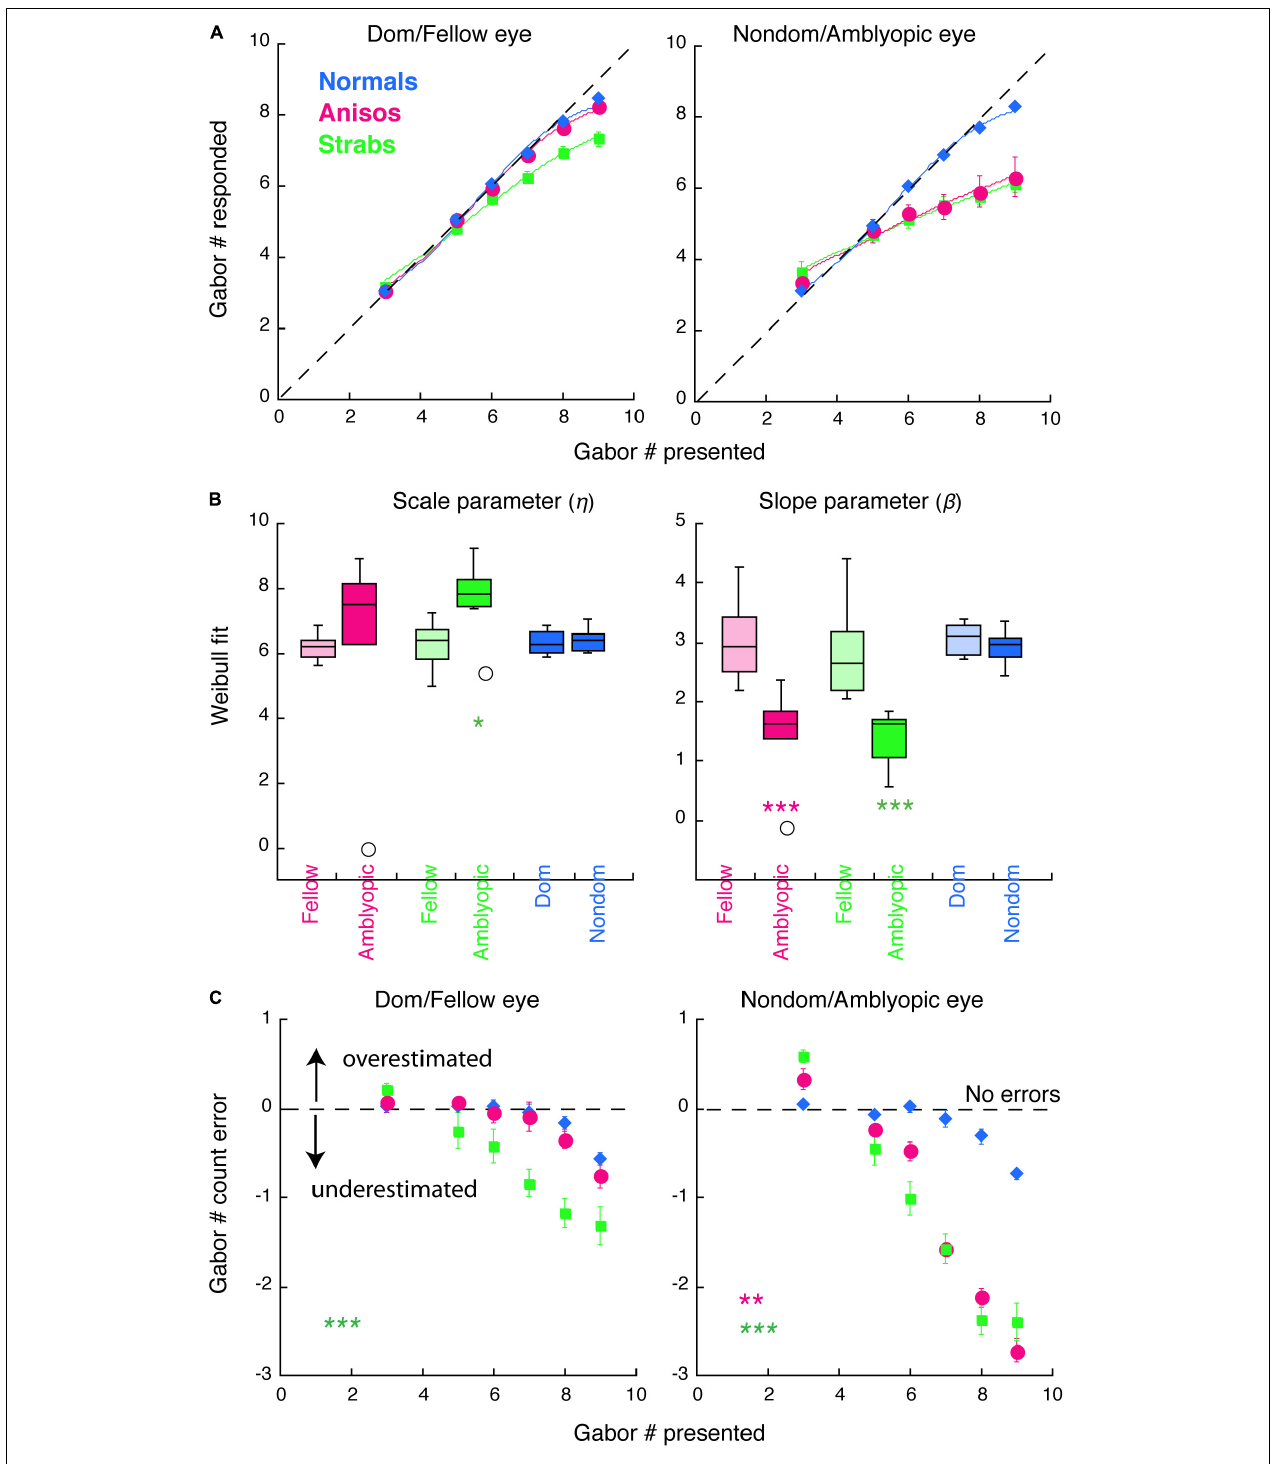
FIGURE 3 | Counting performance in anisometropic and strabismic amblyopes and normal-vision observers when visual features were randomly presented to the left or to the right eye within a block in Experiment 2. (A) Group mean of counting performance. Colors denote the group. Error bars denote SEM. The dashed lines indicate 1:1 ratio between reported and displayed number of Gabors, representing correct estimates. Data below the dashed line indicate underestimates of the number of Gabors. Solid curves are the model fits of Weibull function. (B) Comparison of model fit results from individual participants with scale ( η ) and slope ( β ) parameters. (C) Group mean of counting errors from (A) . *, **, and *** denote p < 0.025 (significance level by Bonferroni correction), p < 0.01 and p < 0.001, respectively.